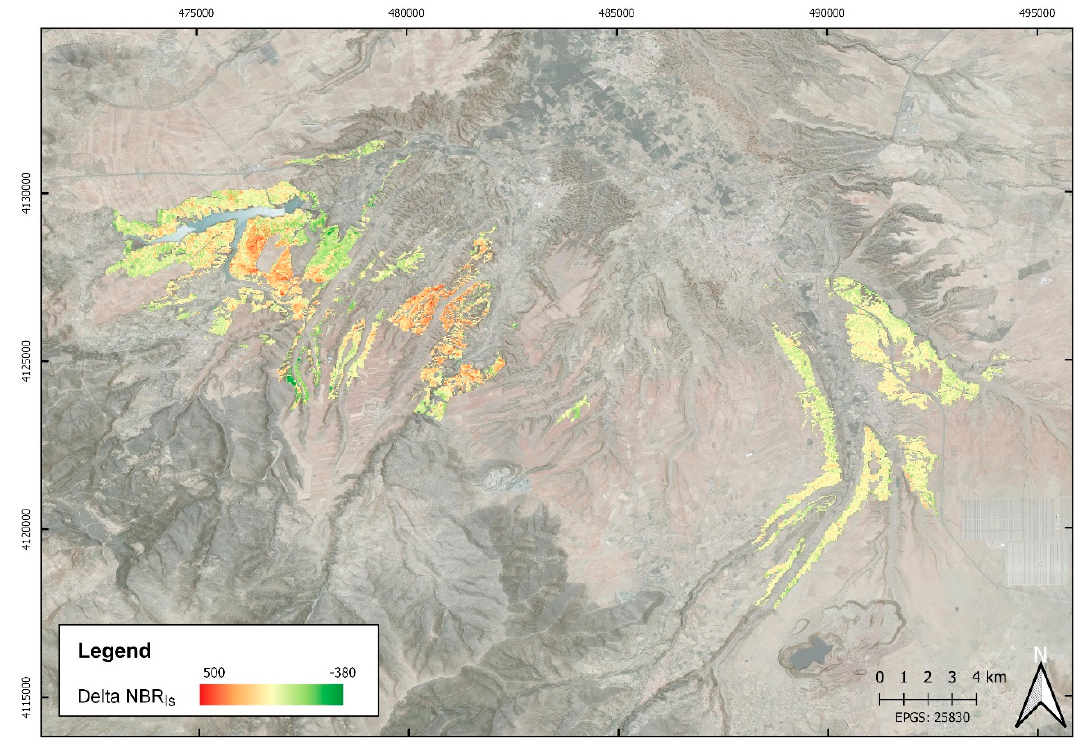
Figure 5. Normalized burn ratio index trajectories of the last segment ( ∆ NBR ls ) values in the study area over the 30-year time period ranging from severe to non-affected defoliation across Pinus halepensis forests in the study area (Sierra de Baza, southeastern Spain).